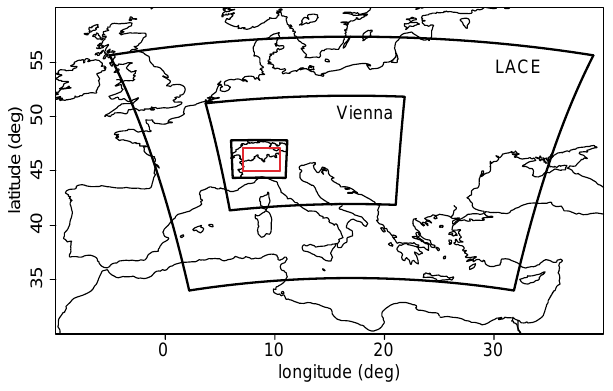
Fig. 2. Simulation domains of ALADIN-LACE, ALADIN- VIENNA and ALADIN-nh. The inner-most frame marks the area shown in Fig.